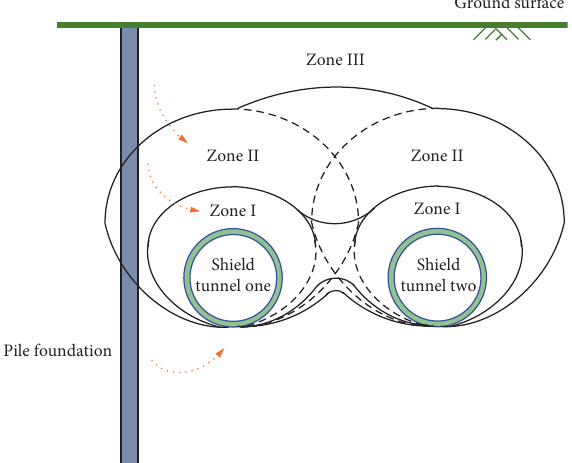
Figure 1: Stratum disturbance zone caused by shield tunneling (perpendicular to the direction of shield